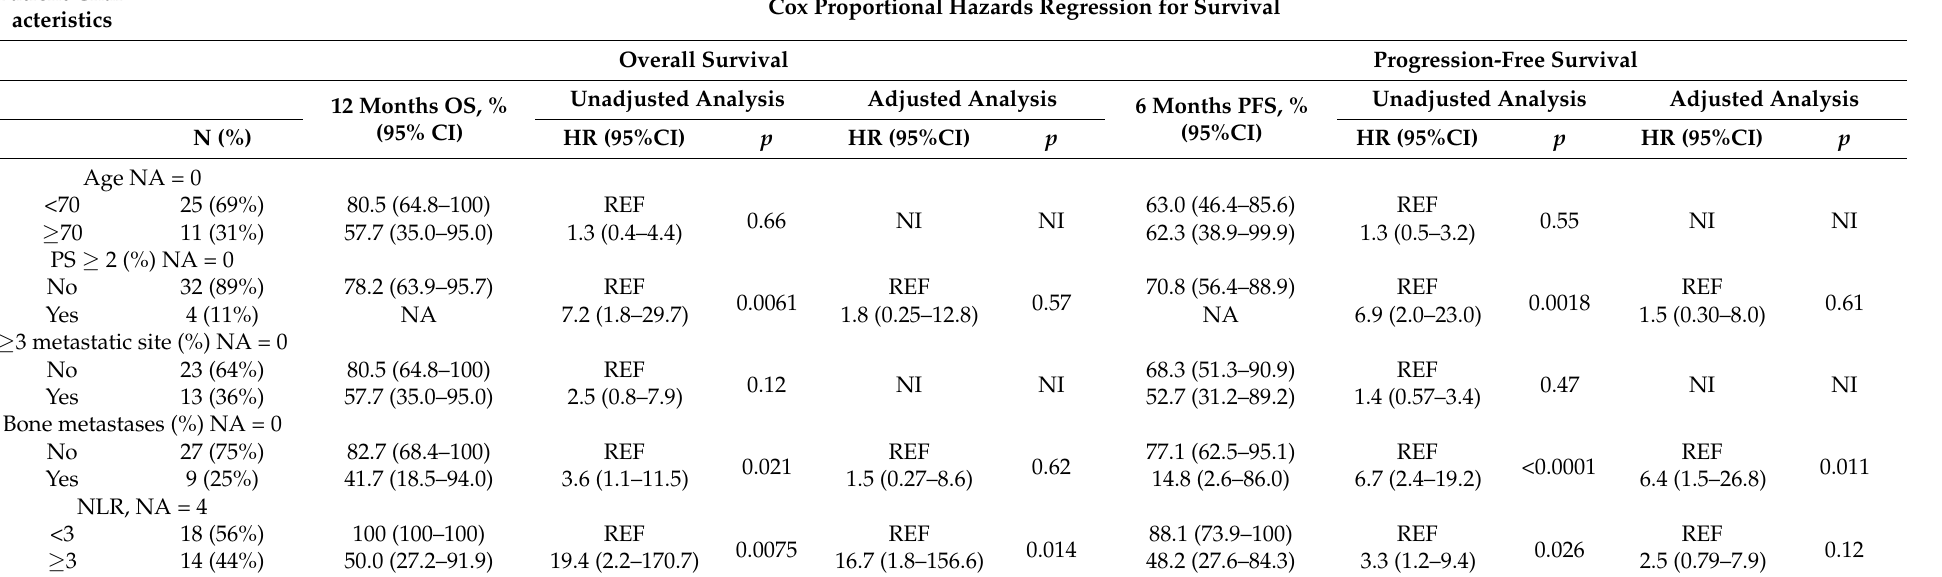
Table 3. Prognostic factors of overall survival and progression-free survival among RCC patients treated with ipilimumab plus nivolumab according to Cox